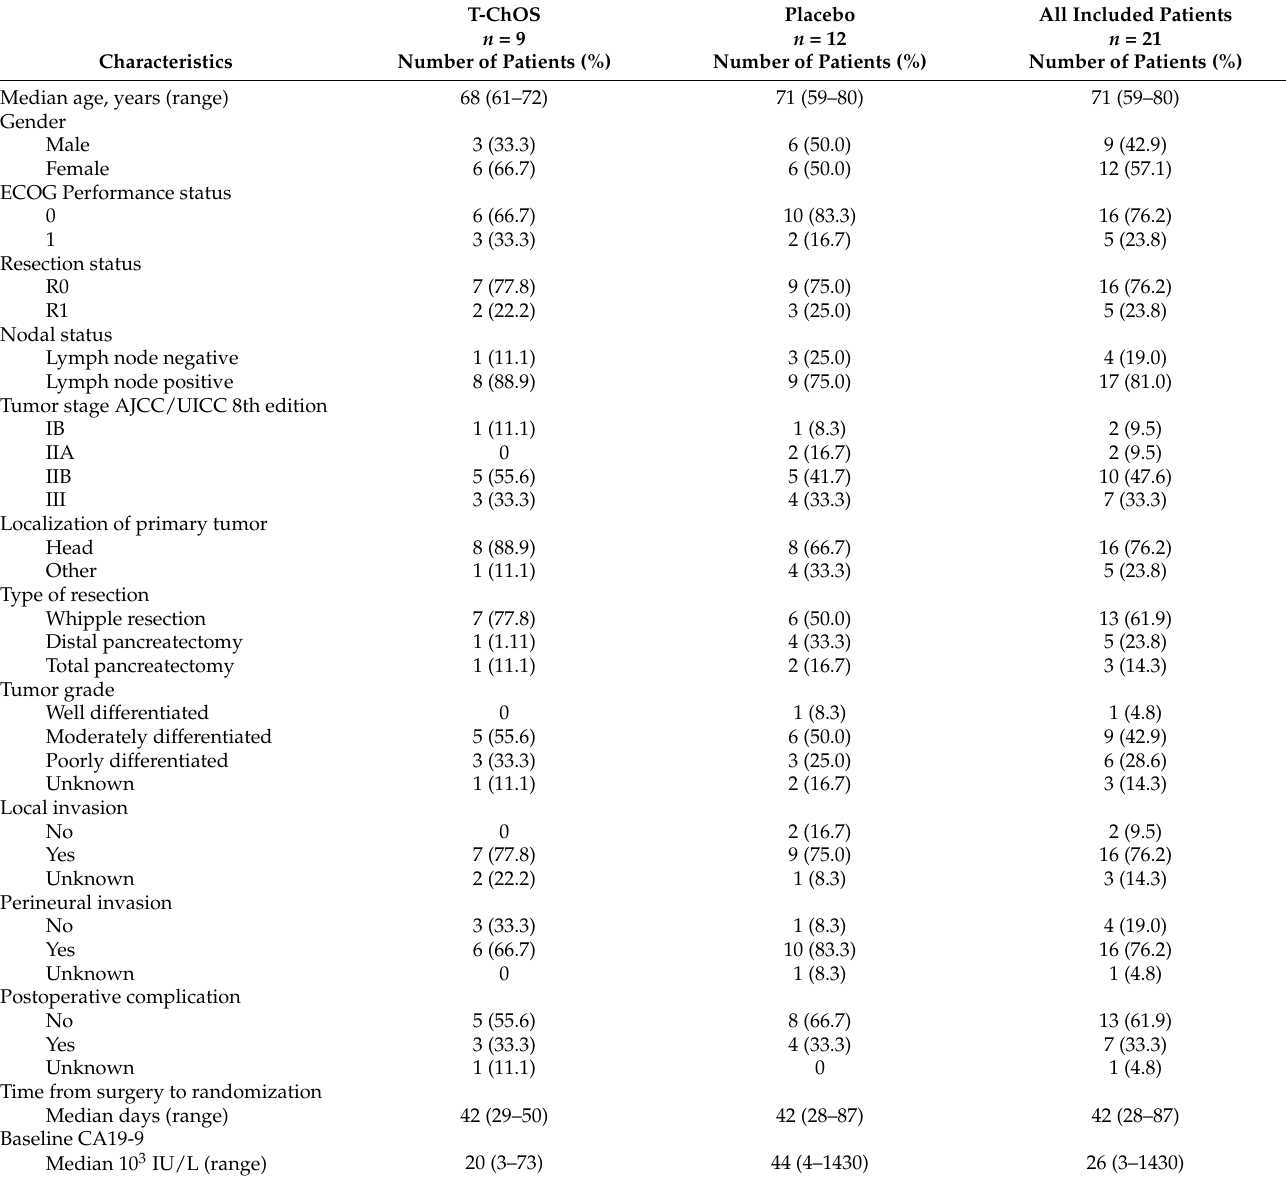
Table 1. Patient